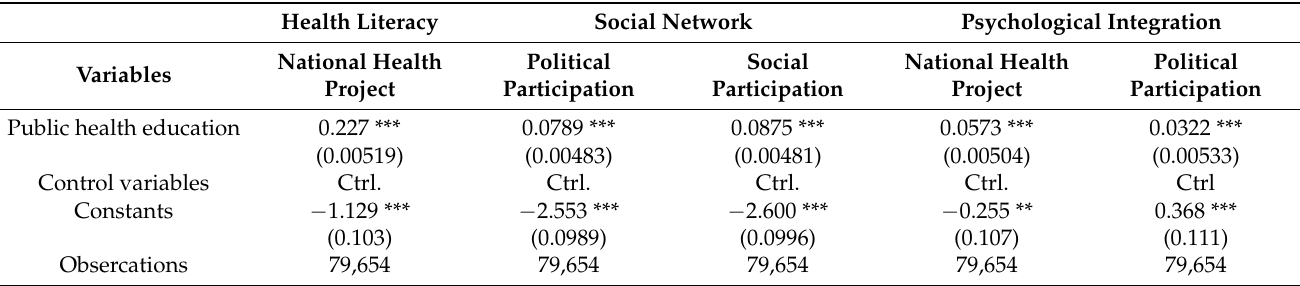
Table 7. The impact of public health education on intermediary